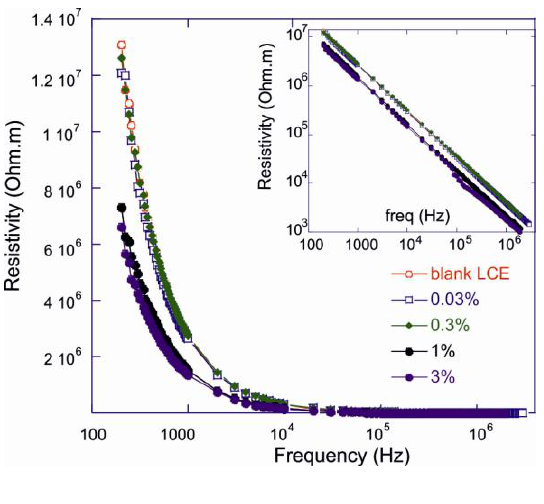
Figure 7. Complex resistivity against frequency, for CNT-LCE composites of different CNT loading. The insert compares the scaling behavior on a log-log scale with that of neat